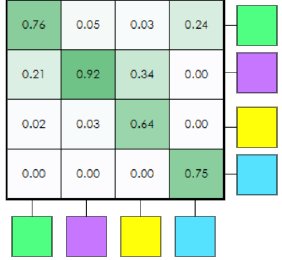
Table 2. Error Matrix; degradation mapping of stela M.E. 18084 through the Random Tree-based ML